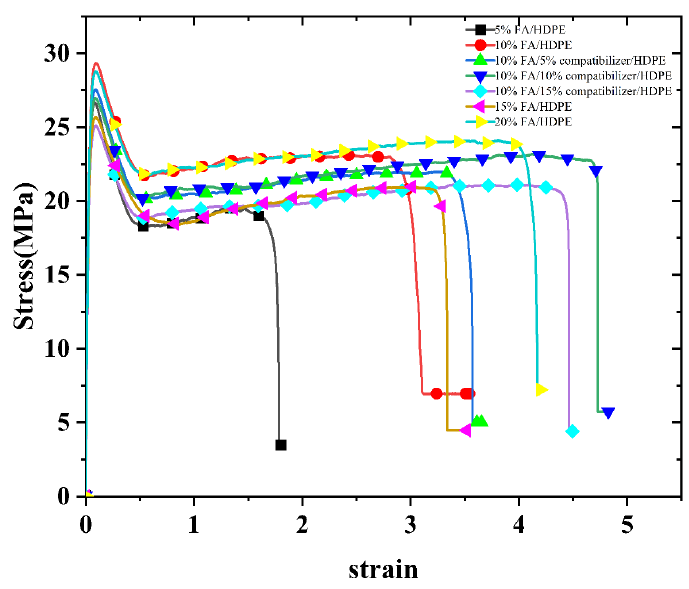
Polymers 2021 , 13 , x FOR PEER REVIEW Figure 5. Stress-strain diagrams of different composites. Figure 5. Stress-strain diagrams of different composites.